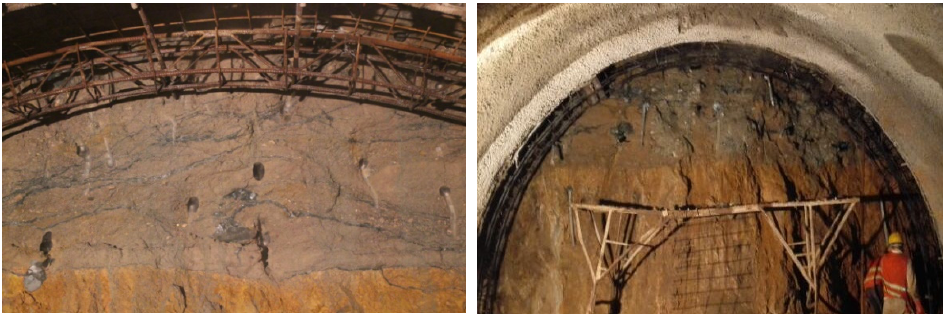
Figure 21. Grout veins exposed in tunnel face.